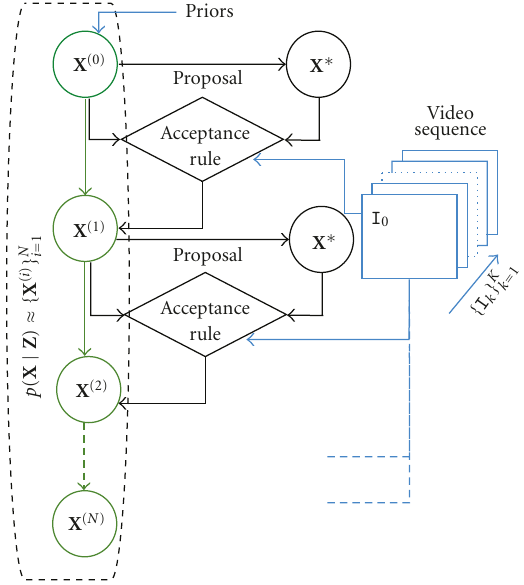
Figure 1: Given a video sequence and an initial state, the method samples the posterior distribution of the trajectory using a random step method